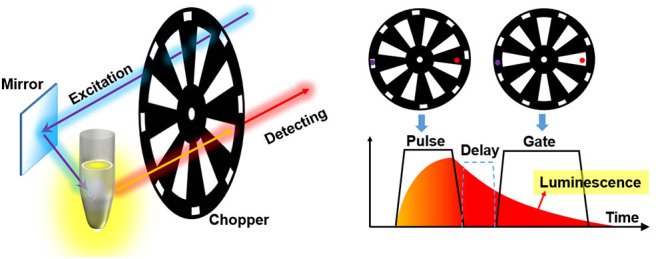
Schematics of gated autosynchronous luminescence detection by a chopper wheel. The diagram (right) shows the time-gated luminescence detection when the wheel rotating.